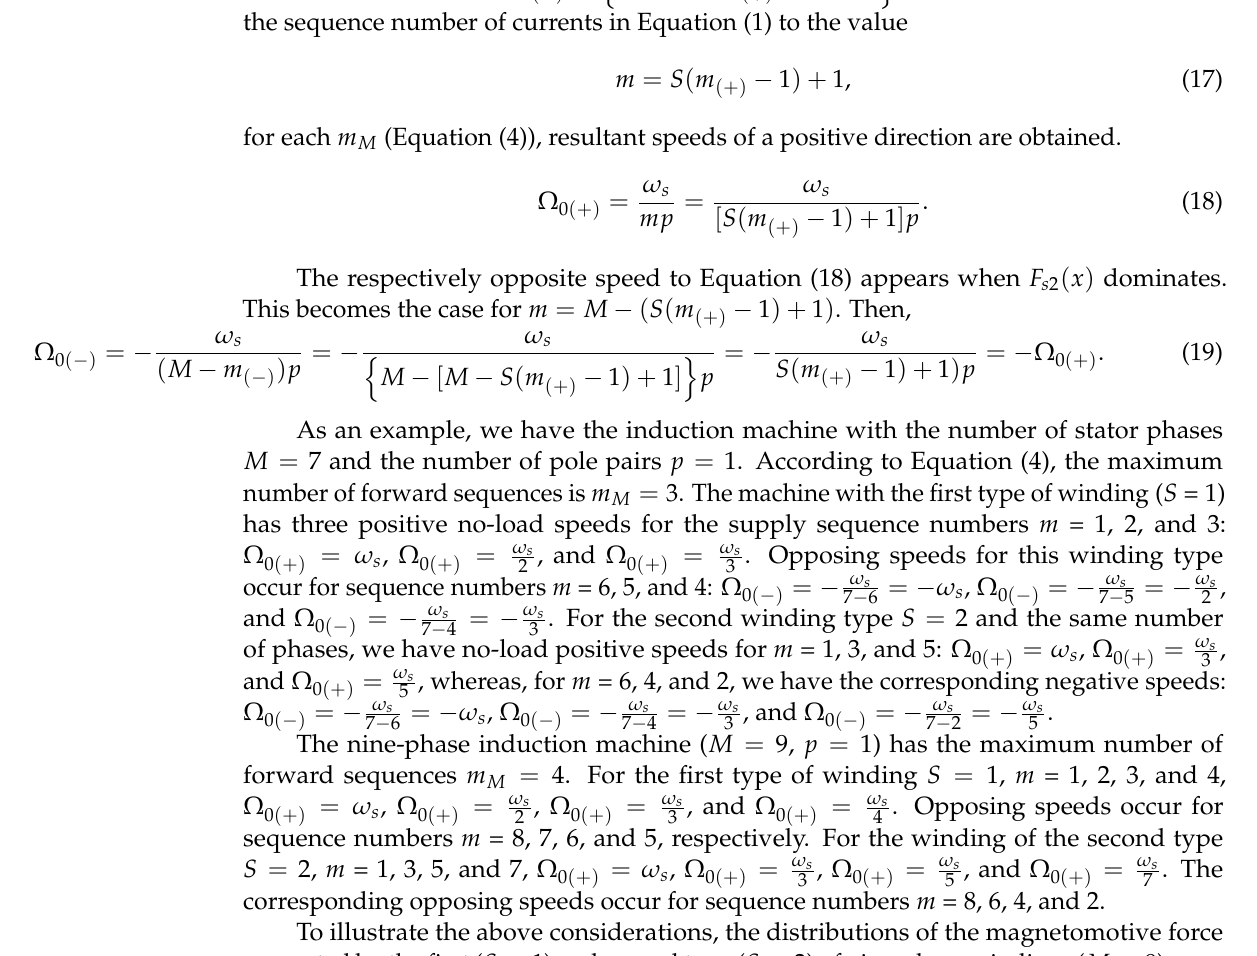
Figure 6. Arrangement of the second type of nine-phase winding ( S = 2, M = 9, c g = 2, α = 360/ Z s = 360/36 ≈ 10°, β = 18 α = 180°); beginnings of the phase windings: 1, 2, 3…; endings of the phase wind- ings: 1 ′ , 2 ′ , 3 ′ , …